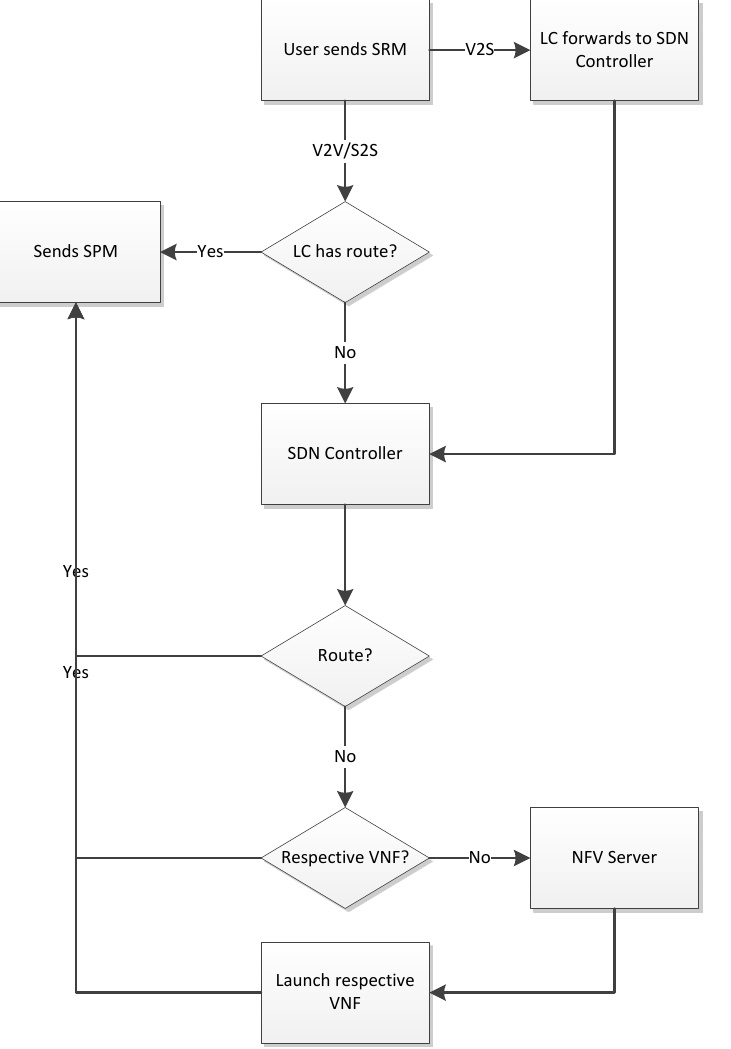
Figure 2. Flowchart representing vehicle-to-vehicle (V2V), ship-to-ship (S2S), and vehicle-to-ship (V2S) communications with integrated